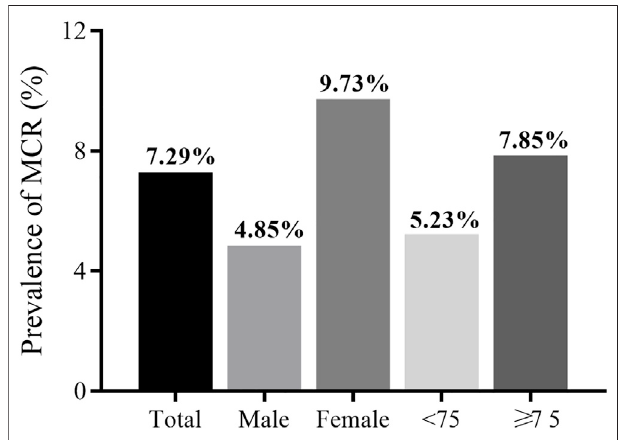
FIGURE 2 | Prevalence of MCR of total study population and different